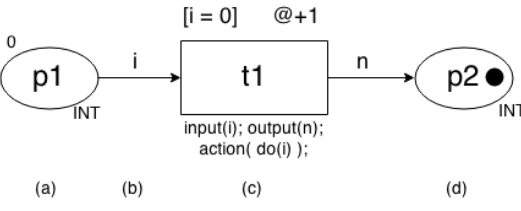
Figure 1. ( a ) place, ( b ) arc and ( c ) transition and ( d ) place with token representations in CPN